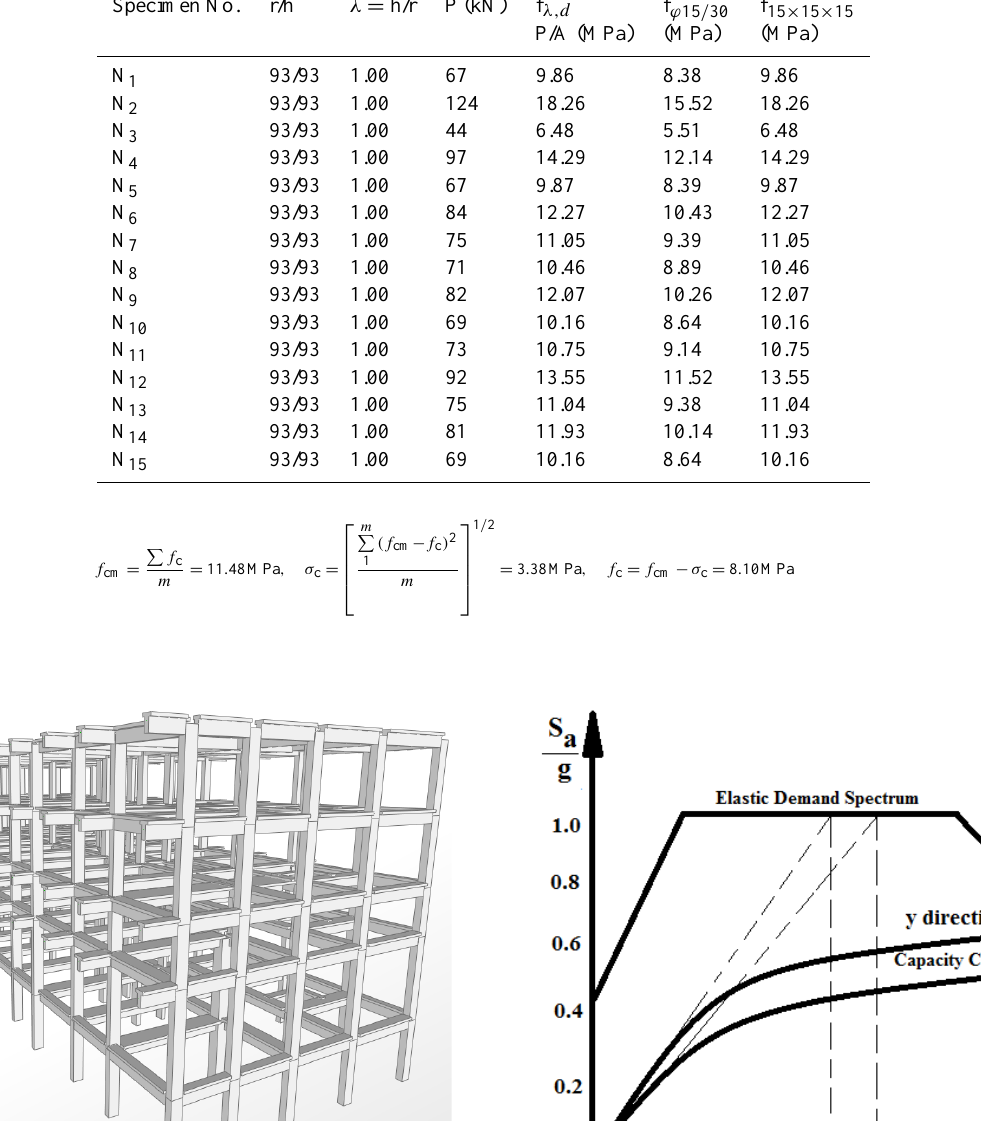
Table 5. Compressive test results of the concrete specimens – case study 1. Specimen No.